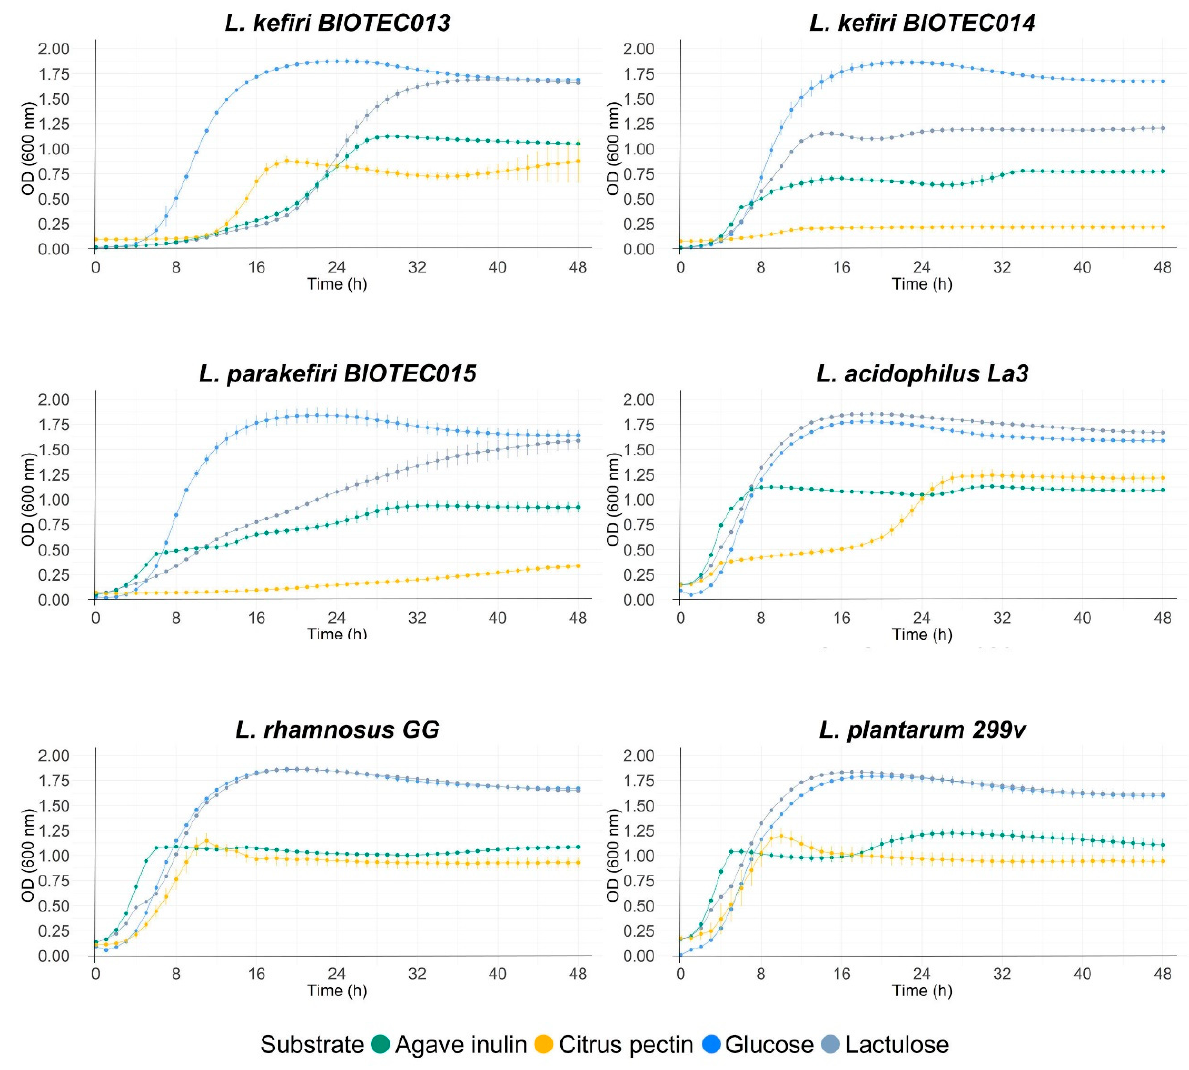
Figure 1. Growth curves of isolated LAB ( Lactoccocus , Lactobacillus , and Leuconostoc ) and yeast ( Kluyveromyces ) on dextrose, agave inulin, lactulose, and citric pectin (at 1%). Standard deviation was calculated, and curves were done in triplicate.